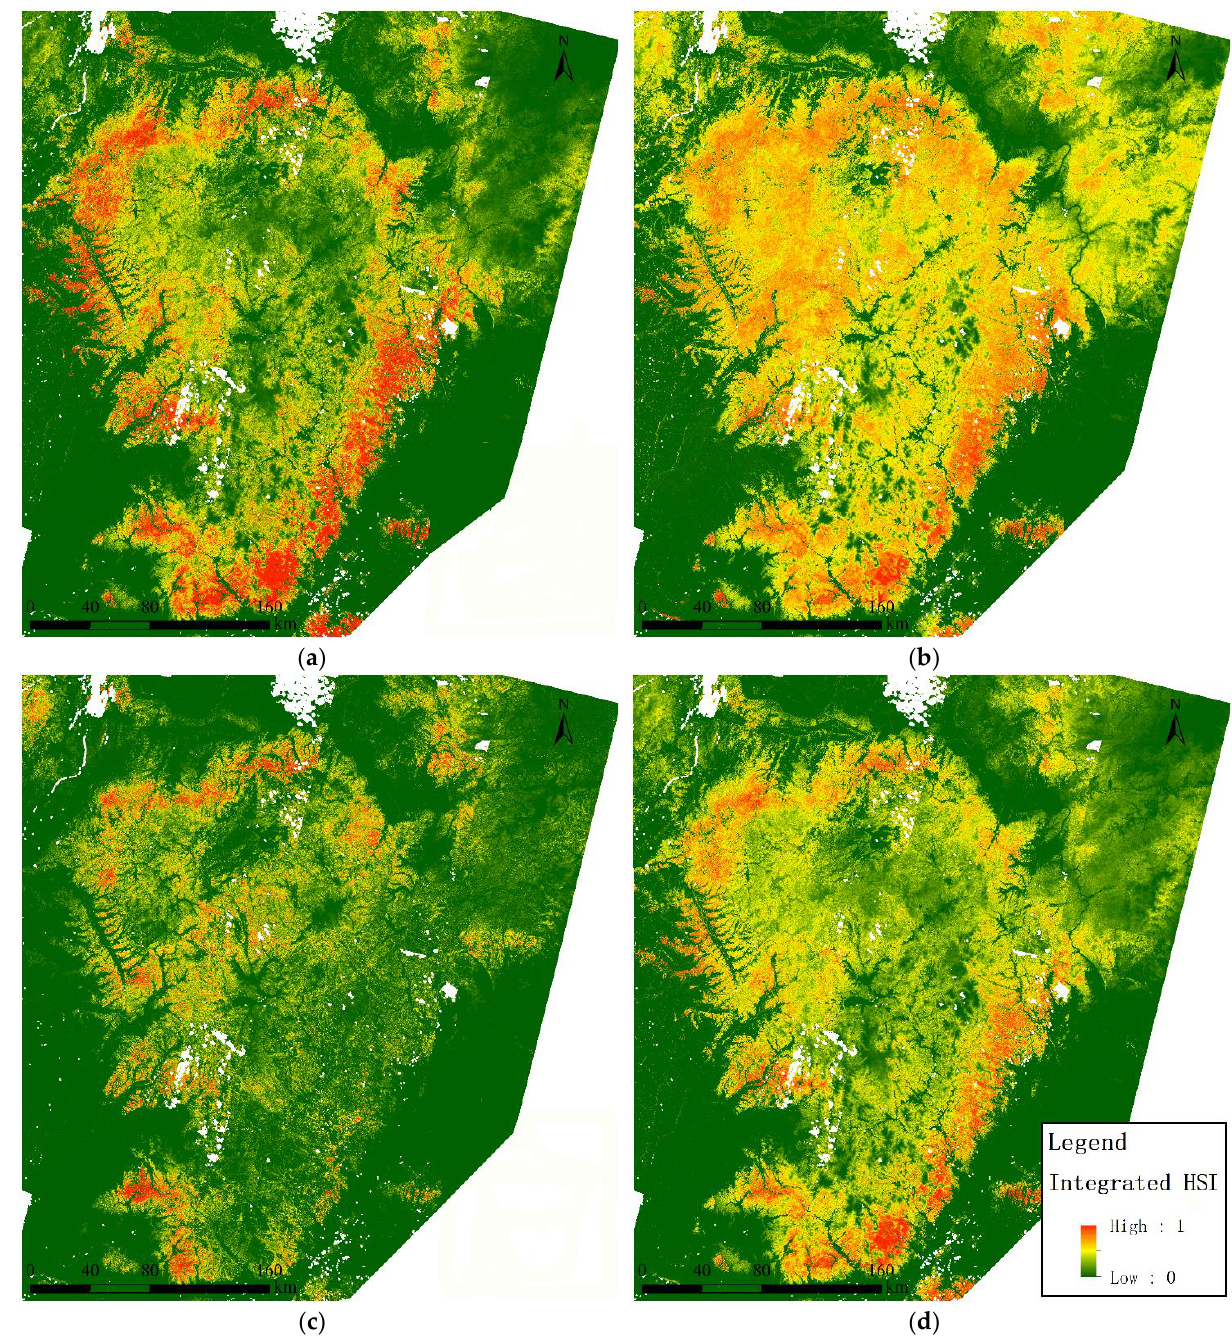
Figure 4. Prediction of potential habitats using MaxEnt modeling for ( a ) wild boar, ( b ) roe deer, ( c ) red deer, and ( d ) an integrated habitat map for the three tiger prey species.